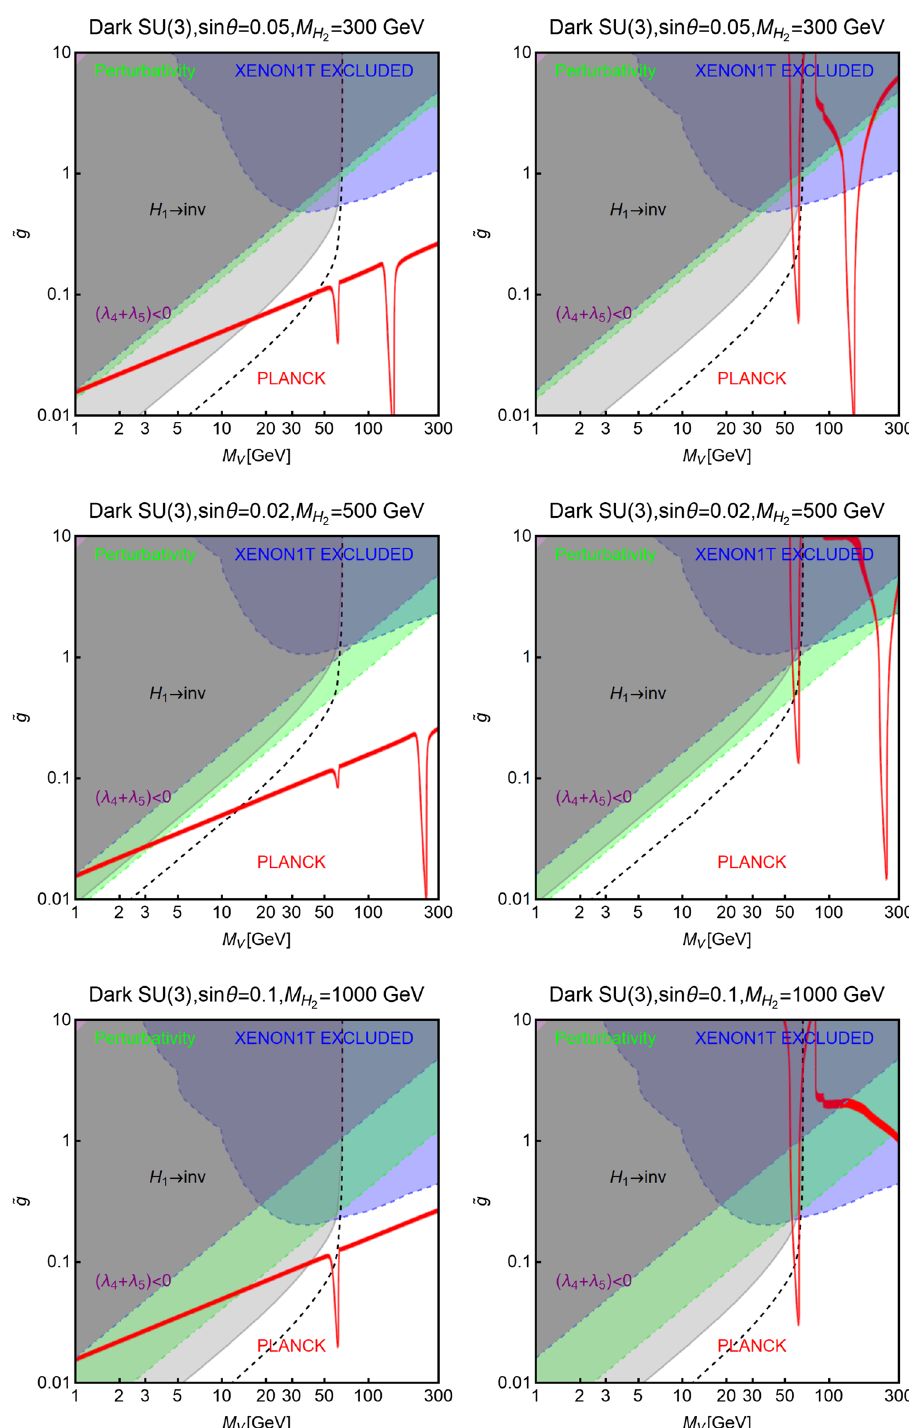
Fig. 19 Summary of constraints for three benchmark scenarios for the dark SU(3) realization with single (left) and multi (right) component DM. The color code is the same as Fig.